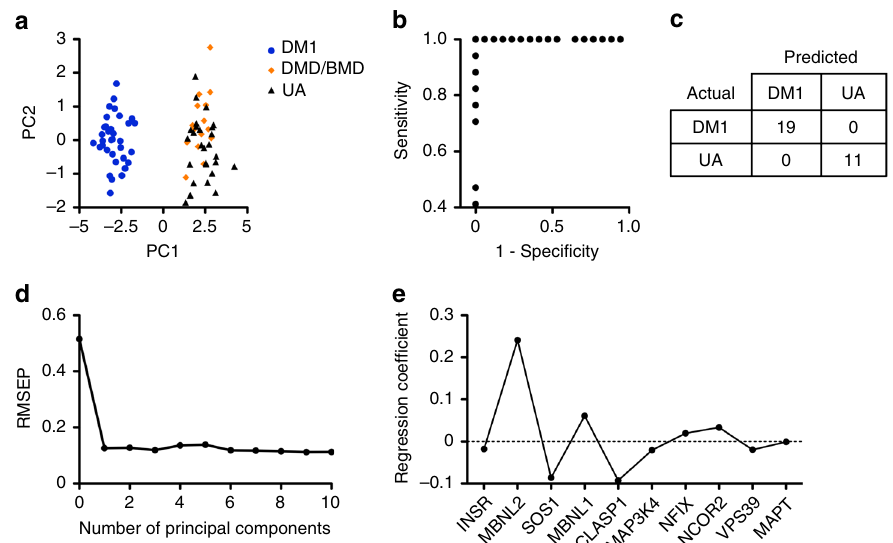
Fig. 4 Principal component analysis and predictive modeling of urine splicing outcomes. Using principal component regression, a linear combination of ten urine exRNA transcripts that show differential splicing in DM1 subjects ( INSR , MBNL2 , SOS1 , MBNL1 , CLASP1 , MAP3K4 , NFIX , NCOR2 , VPS39 , and MAPT ) was used to develop a composite biomarker and predictive model of DM1. a Principal component (PC) score that served as a composite splicing biomarker for each subject ( N = 36 DM1, 15 DMD/BMD, 28 UA). The fi rst and second principal components are plotted. b We combined PC splicing data from the fi rst 45 consecutive DM1 ( N = 23) and UA ( N = 22) subjects enrolled in the study, then randomly assigned 75%, irrespective of genotype, to a training set, and the remaining 25% to an independent validation set 32 . Using the training set and a threshold of 0.5 (see Methods), we developed a predictive model that produced zero false positives and false negatives in a fi vefold cross validation test. The receiver operating characteristic (ROC) curve is shown. c The predictive model accurately distinguished DM1 from UA in all 11 subjects of the validation set used to test the model ( N = 6 DM1, 5 UA), and in the next 19 consecutive subjects that were enrolled in the study after model implementation ( N = 13 DM1, 6 UA), for a total of N = 30 that were evaluated using the model. d Root mean square error of prediction (RMSEP) as a function of the number of principal components. e Regression coef fi cients, calculated as